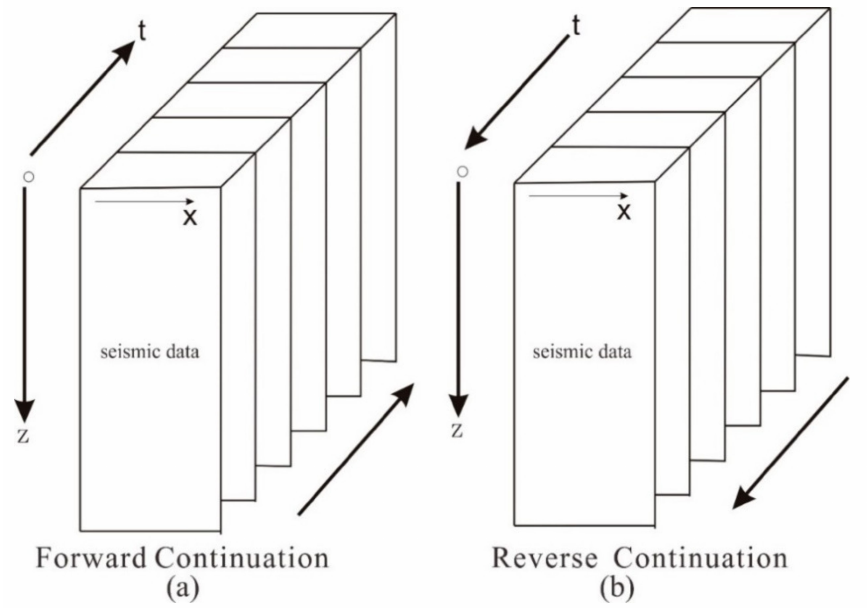
Figure 1. The principle of RTM imaging: ( a ) forwarding continuation; ( b ) reverse continuation.